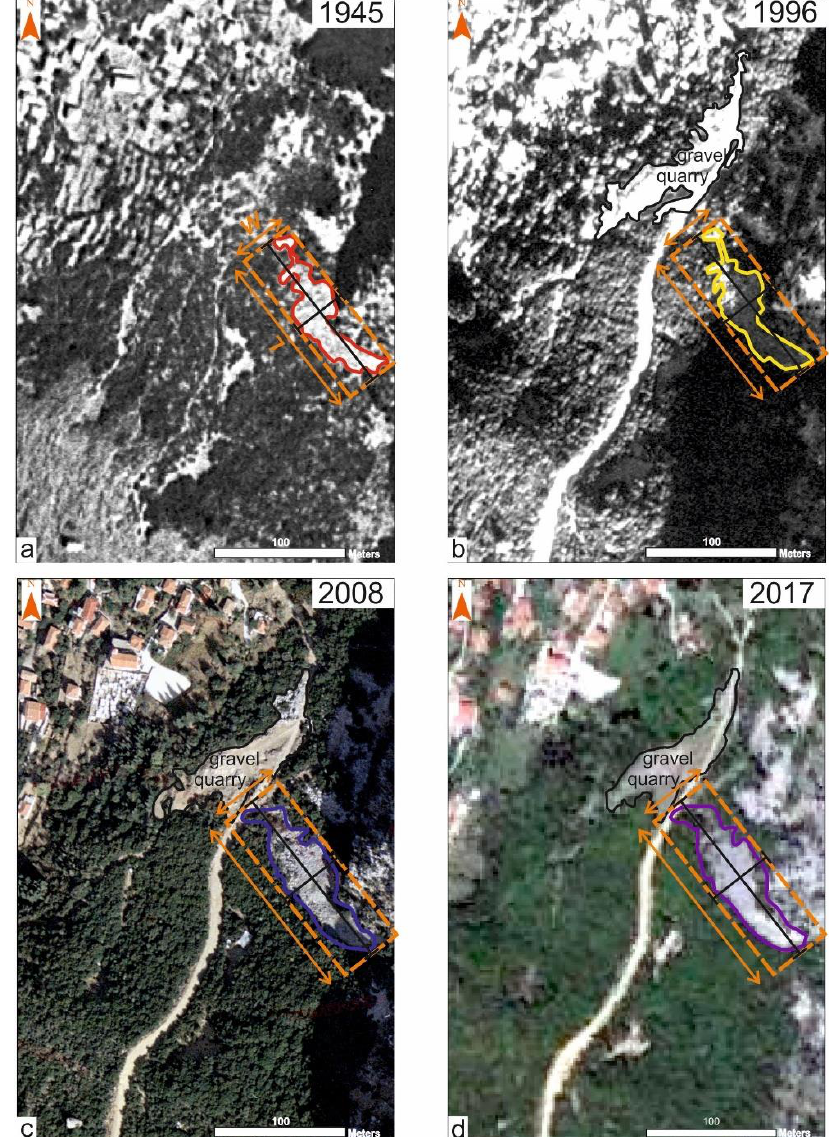
Figure 2. An example of the changes to landslide areas identified from the orthophotos. The orthophotos show, from ( a – d ), the perimeter of the digitized polygon area. Asymmetrical crosses (in black) represent the evolution of length and width that appeared in Figure 4.